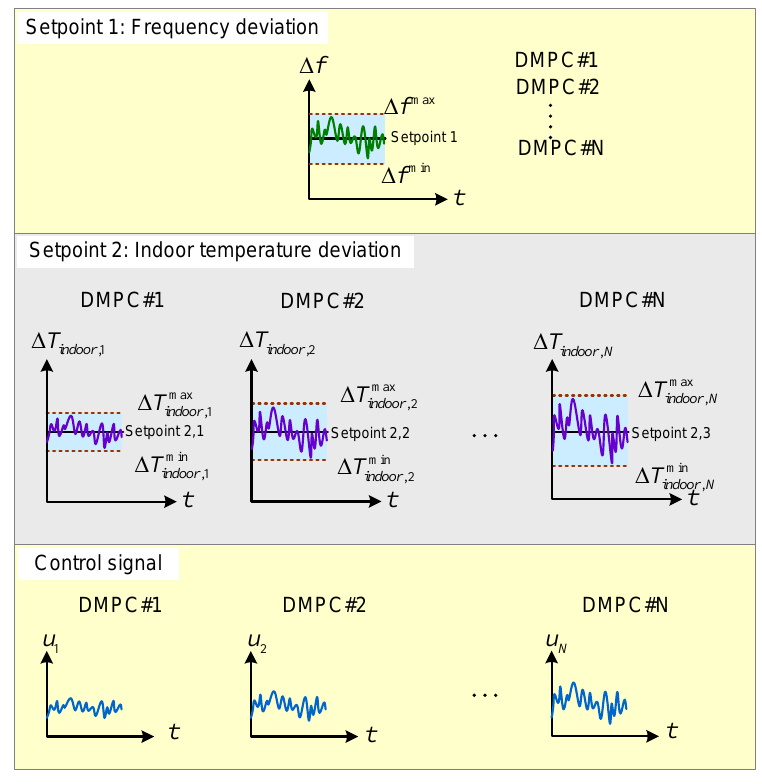
Figure 6. Details of setpoints and control signal of DMPCs for IACs control.